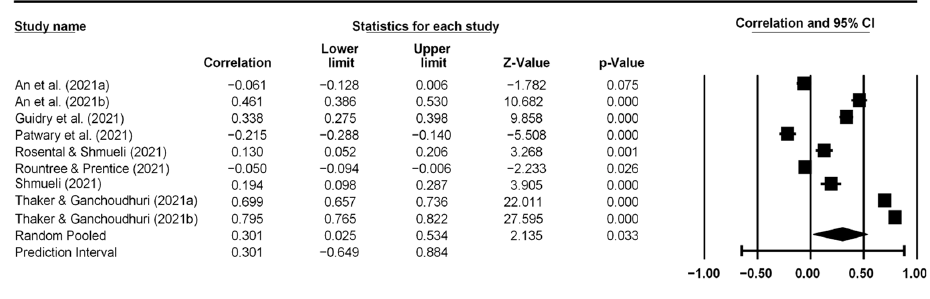
Figure 4. Forest plot showing perceived behavioral control and vaccination intention correlation.